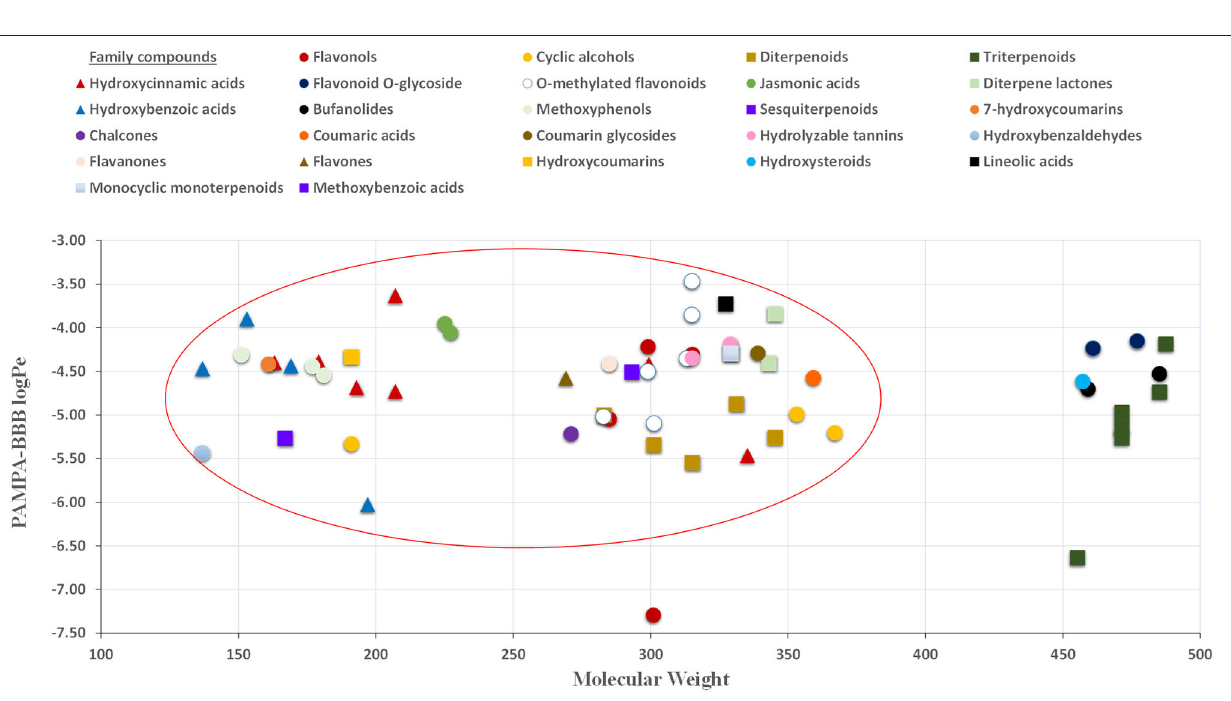
FIGURE 2 | Relationship between PAMPA-BBB logPe and MW (molecular weight)